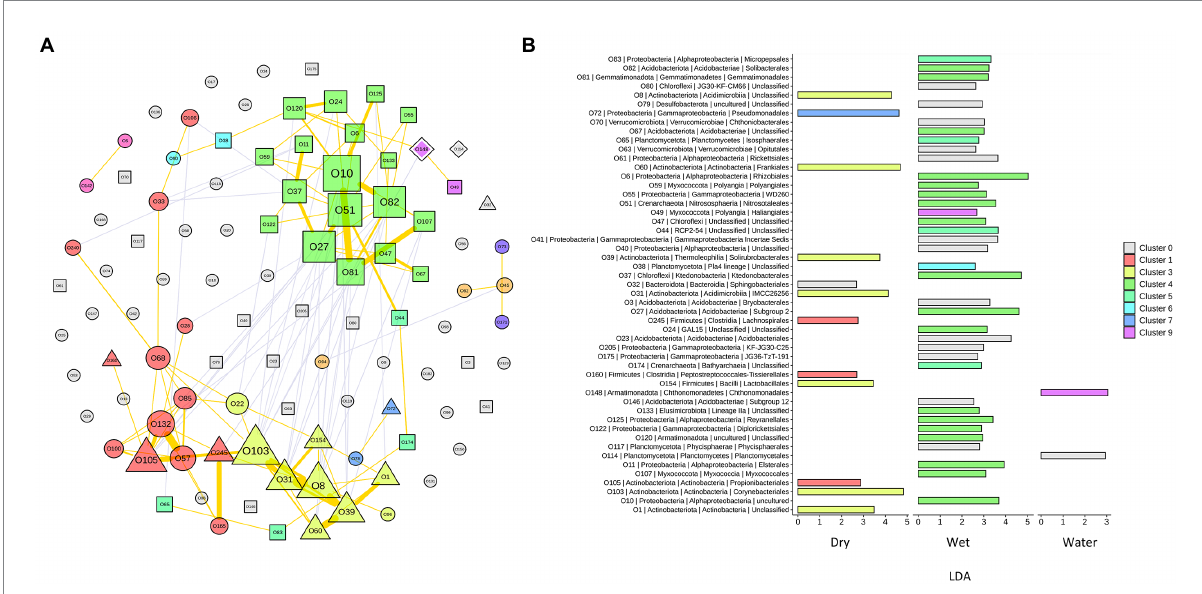
FIGURE 6 Network analysis of the microbial communities from Imawarì Yeuta cave. (A) Co-occurrence network of the most abundant orders (with relative abundance >1% in at least 5 samples) in the communities. Node codes (“O” followed by a number) correspond to the order/taxonomy shown in panel B, node color indicates the order assignment to each network cluster. Node size scales according to the node’s centrality. Node shapes correspond to the orders significantly enriched in DRY (triangle), WET (square), and WATER (diamond) groups. The circle shape indicates order that is not significantly enriched in any of the three sample groups. The yellow lines indicate positive interactions, and grey lines indicate negative interactions. The thickness of the lines is proportional to the correlation strength. (B) LDA scores of the orders included in the network analysis. The color shown in the legend indicates the cluster membership. C0 (in grey) indicates those orders that do not belong to any